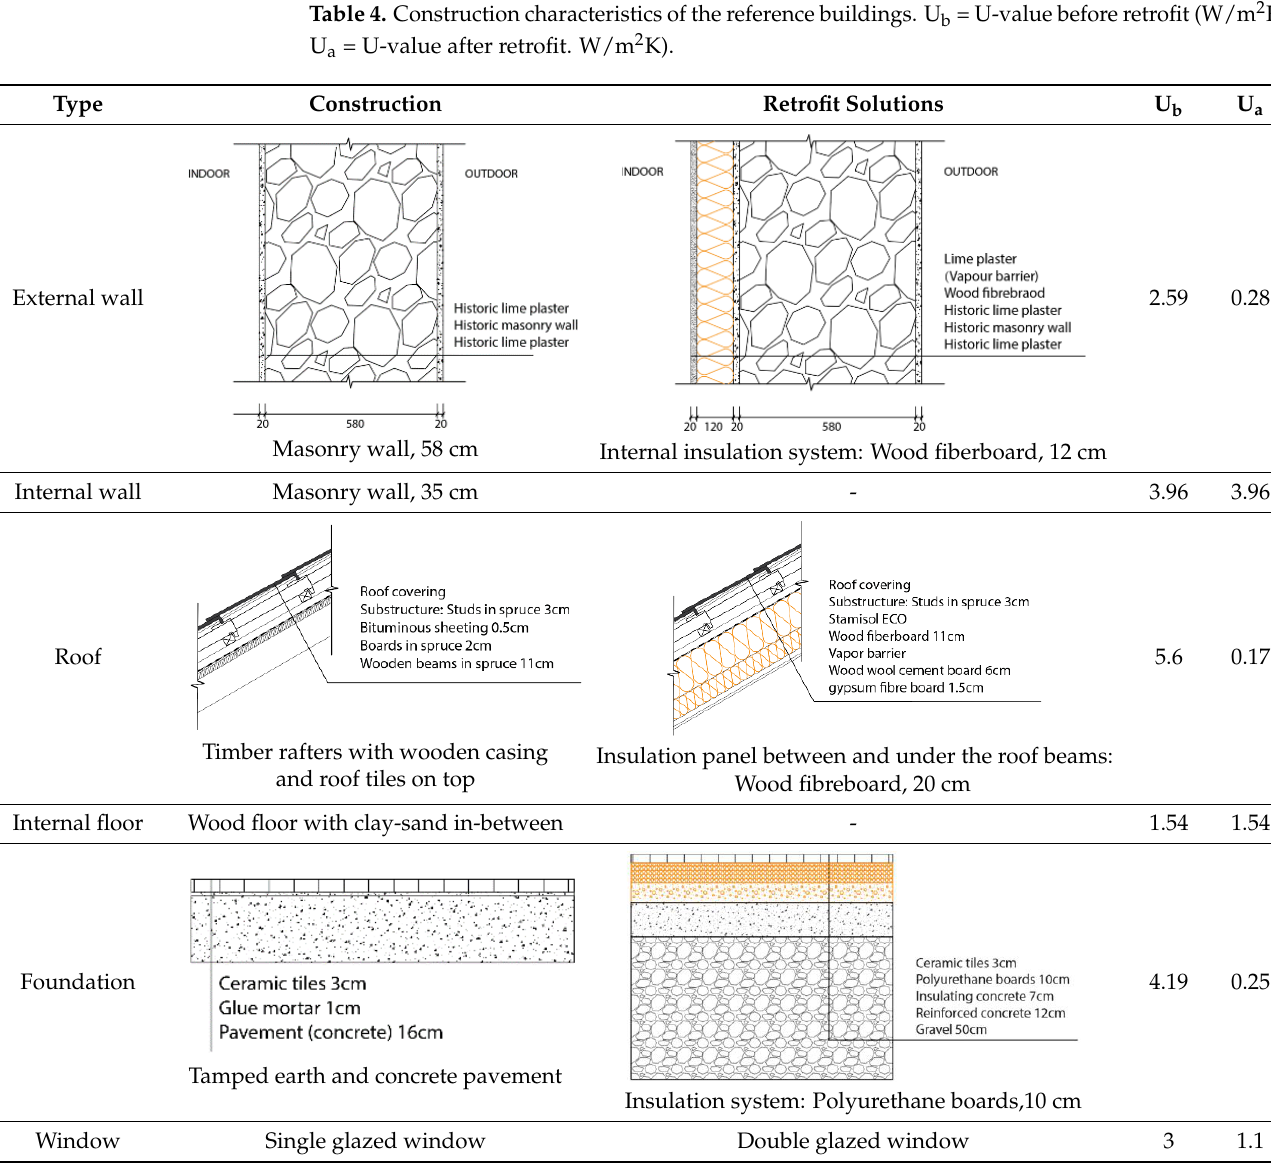
Figure 5. Simulation scenarios defined according to building and climate conditions, P = Present climate condition (2008 – 2011); F1 = Near future climate condition (2041 – 2050); F2 = Far future cli- mate condition (2091 – 2100); Un-retrofitted = historic building in the original state; and Retrofitted = historic building undergone energy retrofit. To verify the effectiveness of the envelope retrofit, the energy performance simula- tion focuses on space heating, while other end uses such as hot water supply and lighting are not included. The heating energy demand of the building is calculated based on the temperature setpoint of 22 °C (occupied), which is the comfort temperature recommended by CIBSE Guide A [34]. The heating period of Climate zone I is defined according to the Italian regulation, based on Heating Degree Days (HDD): 15 October – 15 April, 14 h/day. Since there are no limitations to heating period and heating hours for Climate zone II, a heating period from 15 September to 15 April is defined based on the comparison of HDD between Climate zone I and II. The occupancy (Figure 6), lighting, and electric appliances profiles are based on ISO 17772-1 [35] and the 2014 Building America House Simulation Protocols [36]. 17772-1 offers an informative occupant schedule for the energy calculations of residential buildings, shops, and offices. However, this schedule does not make any distinction between the living room and bedroom, which makes the comfort assessment inaccurate. Therefore, the fraction of occupants in 17772-1 is distributed for the living room and bedroom according to their ratio in the 2014 Building America House Simula- tion Protocols.